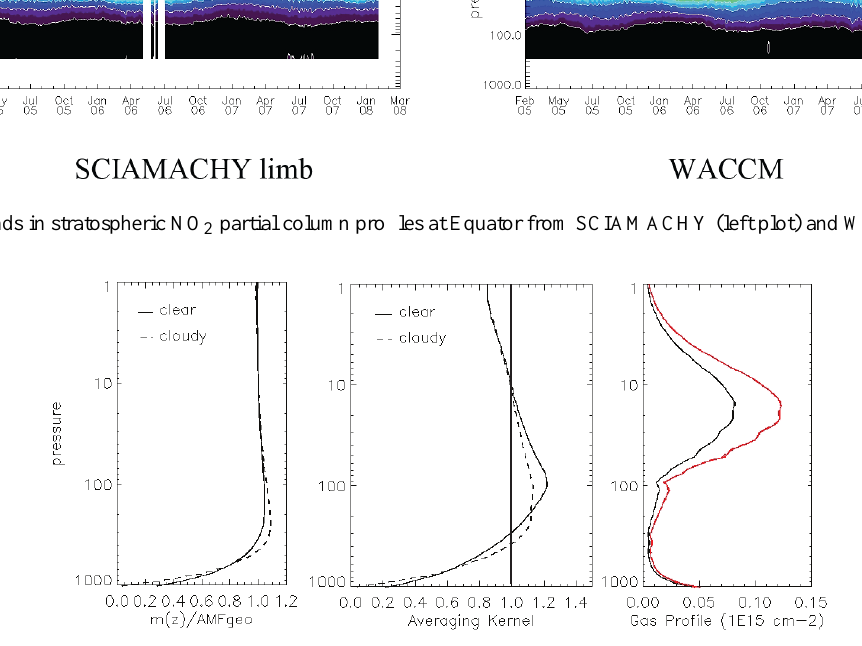
Figure 10. Normalized scattering sensitivity m(z)/M geo , averaging kernel A(z) and vertical distribution of assimilation increments in clear- sky (continuous line, cloud radiance fraction CRF < 25%) and cloudy (dashed line, cloud radiance fraction CRF > 75%) unpolluted condi- tions on 21 March 2005 (global averages), following Eq. (10). On the right panel, the black and red lines refer to before and after adjustment,